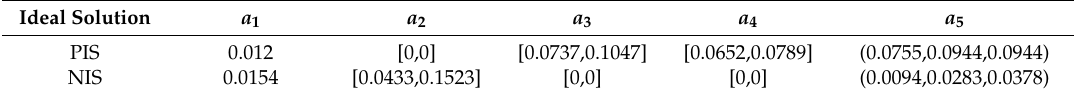
Table 6. Ideal solutions corresponding to the five attributes.